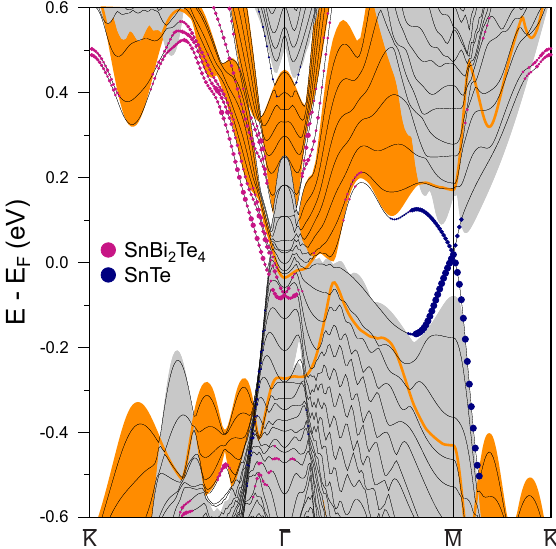
Figure 4. Electronic structure of the smooth SnBi 2 Te 4 /SnTe interface. Orange (grey) background corresponds to SnBi 2 Te 4 (SnTe) projected bulk band structure. The radii of the purple (navy blue) circles reflect the localization of the states in the near-interface SnBi 2 Te 4 (SnTe)